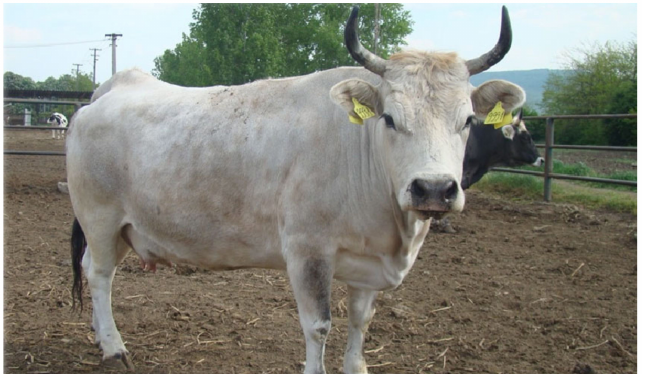
Figure 1. The Grey Steppe cattle within the Research and Development Station for Cattle Breeding, Iasi, Romania (original photograph).